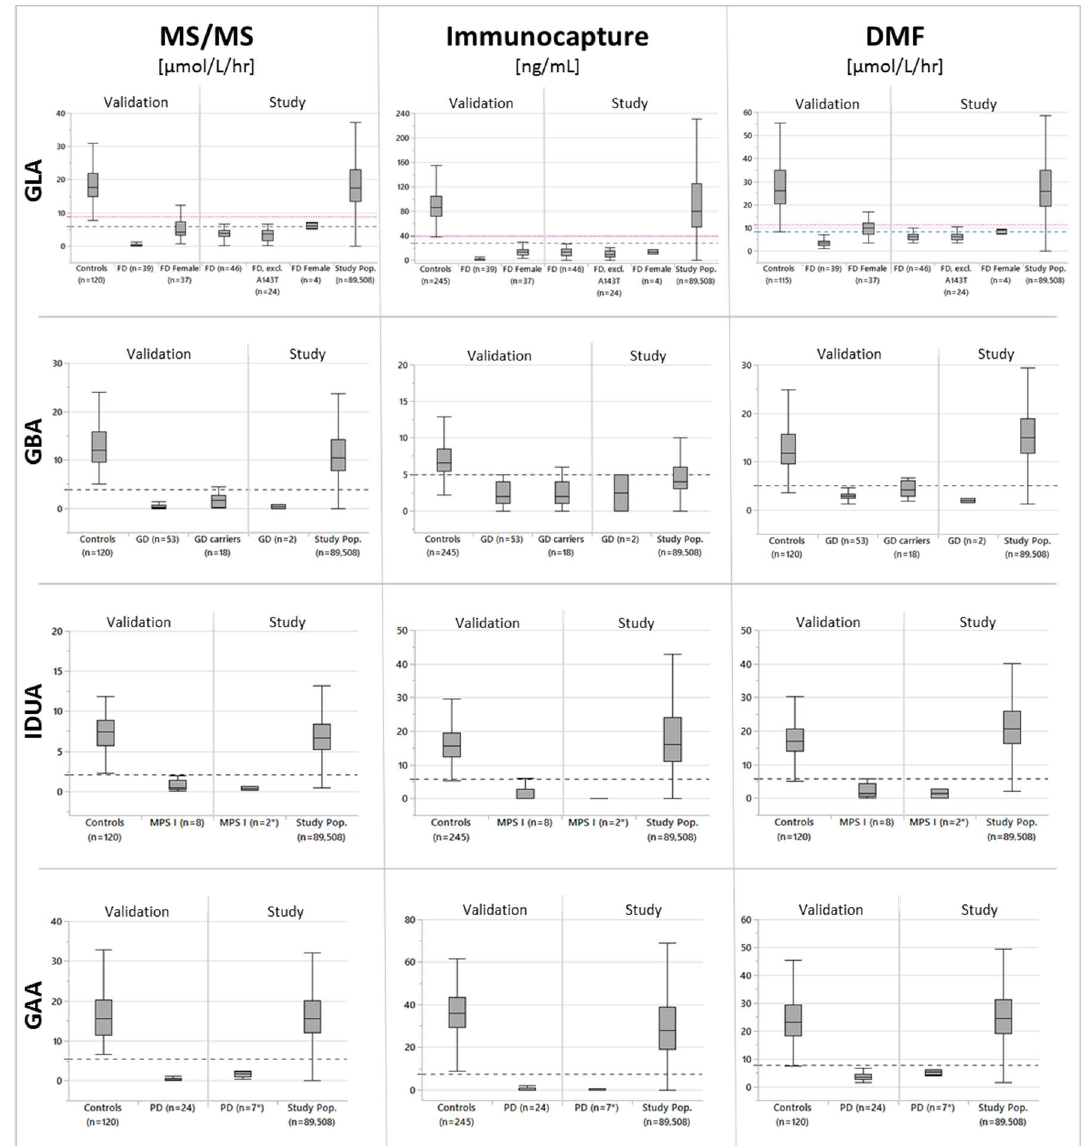
Figure 1. Validation and study data for each of the three screening platforms and enzymes represented as quartile plots (upper whisker end: 1.5 × interquartile range; top of box: 75th percentile; line in box: median; bottom of box: 25th percentile; lower whisker end: − 1.5 × interquartile range). The horizontal lines indicate the chosen cuto ff s during assay validation (Table 2). GLA cuto ff s for females and males are provided in red and blue, respectively. FD, Fabry disease; GD, Gaucher disease; MPS I, mucopolysaccharidosis type I; PD, Pompe disease. * Includes one specimen from a known patient with PD and MPS I that was added randomly to the study population to test the systems.